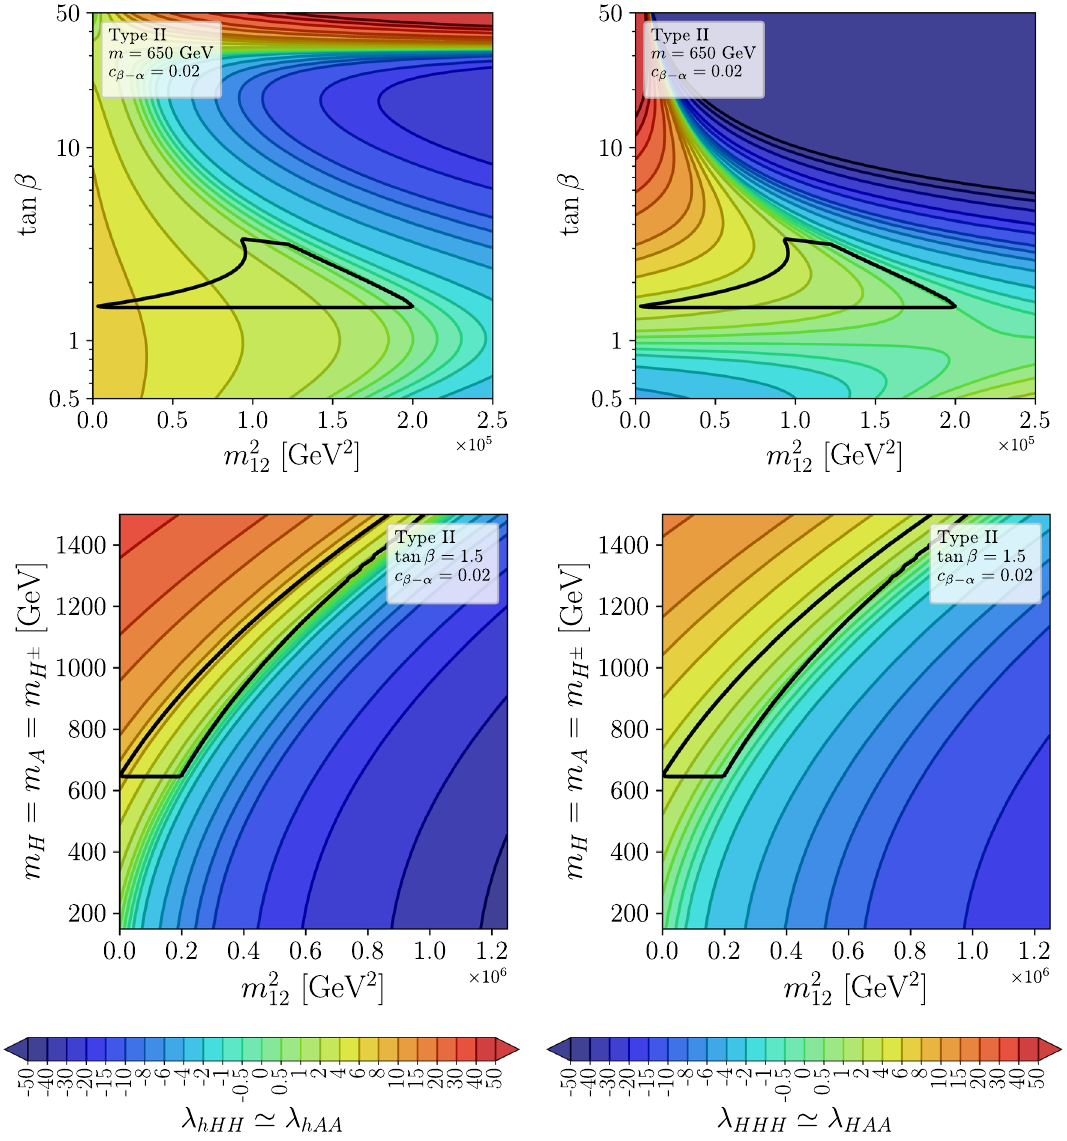
Fig. 16 Predictions for λ hHH (cid:7) λ hAA and λ HHH (cid:7) λ HAA in the 2HDM type II benchmarks planes 4 (upper row) and 5 (lower row). The regions inside the solid black lines are the parts of the parameter space that are allowed taking all theoretical and experimental constraints (see